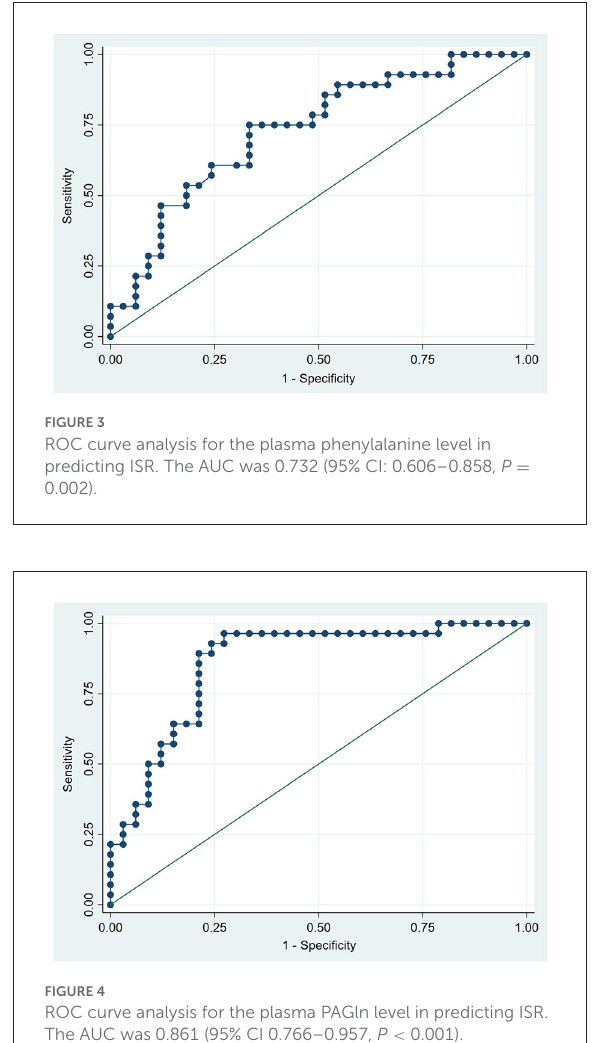
while an AUC < 0.5 represents the absence of predictive ability